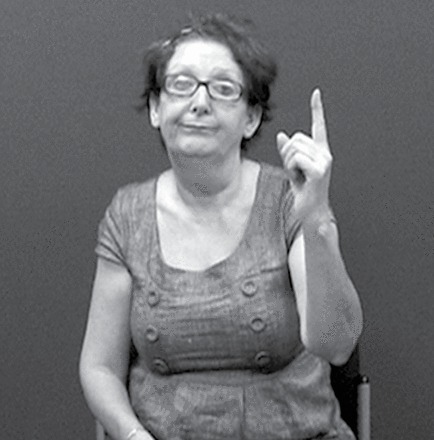
Whole entity construction. The signer’s hand represents an upright entity.